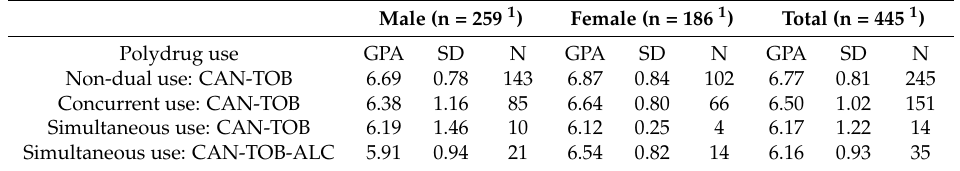
Table 3. GPA by gender and patterns of polydrug